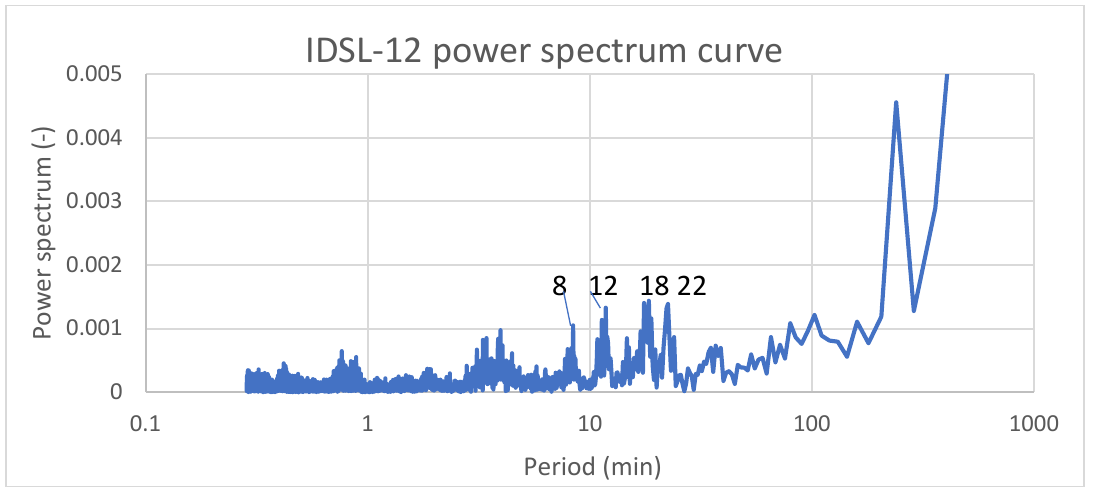
Figure 8. Sea level measured in Le Castella, Italy.